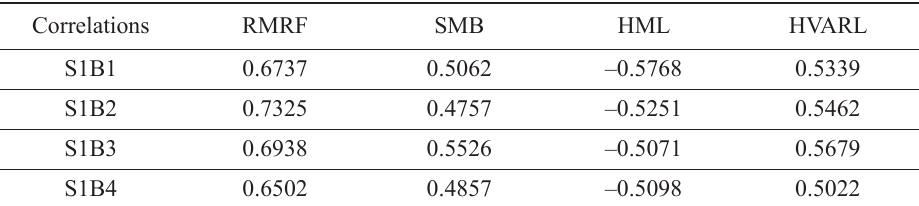
Table 3. Correlations of 25 portfolio returns with RMRF, SMB, HML, and